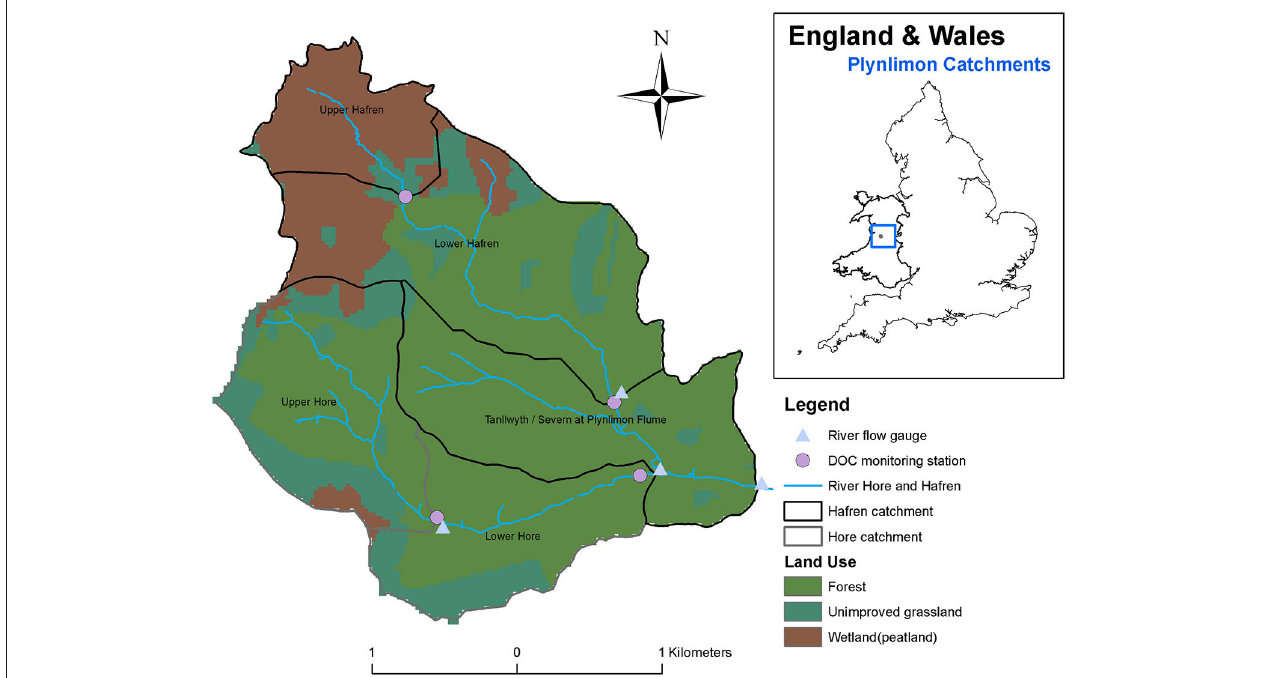
FIGURE 1 | Plynlimon catchment with the Hore and Hafren sub-catchments.